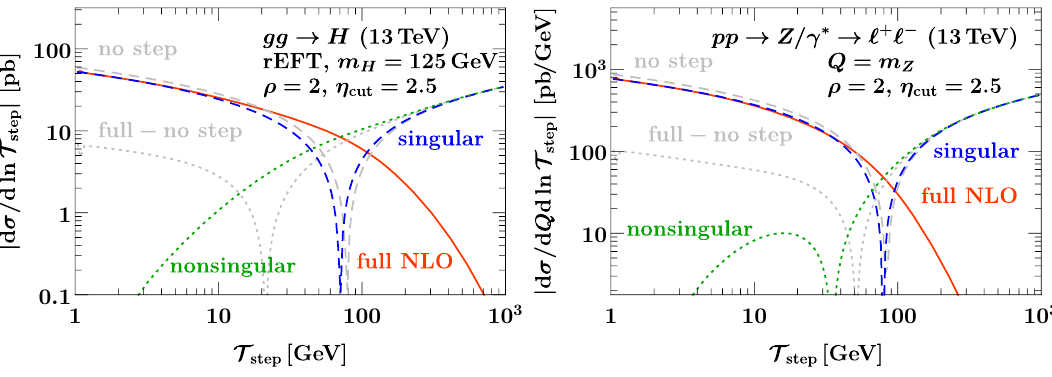
( (cid:11) s ) (LO 1 ) O T step =p cut = 2 for gg H (left) and Drell-Yan at T T !